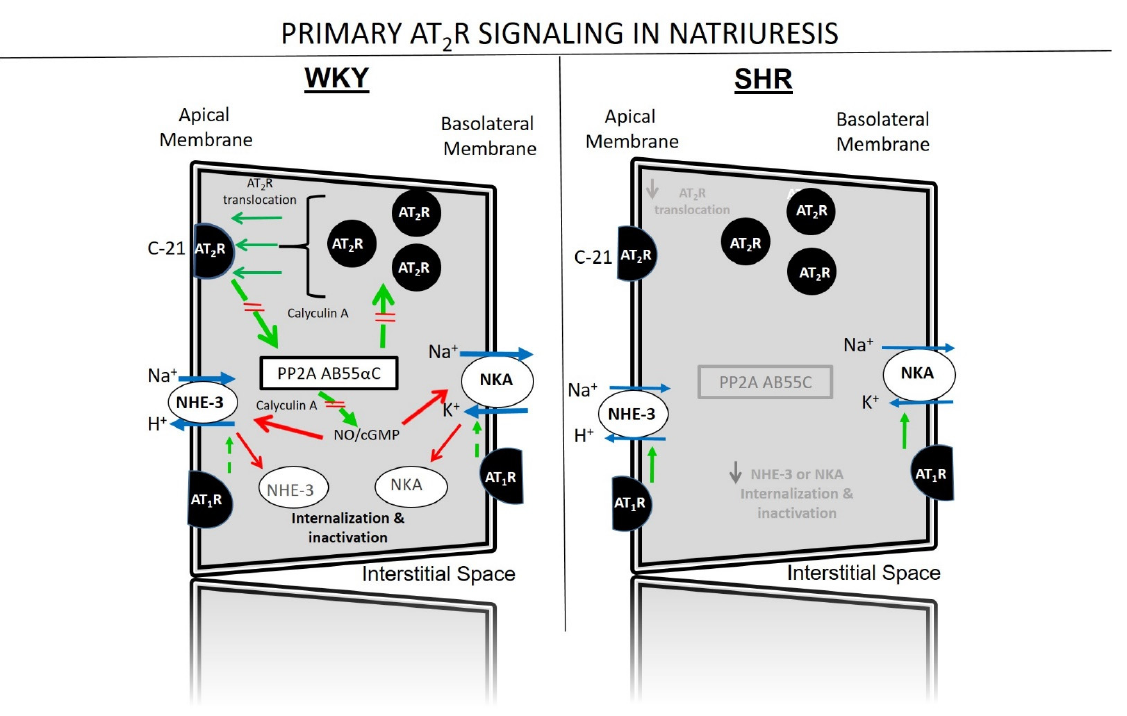
Figure 2. Schematic representation of the angiotensin II (Ang II) type 2 receptor (AT 2 R) protein phosphatase 2A (PP2A) AB55 α C signaling pathway by which receptor activation with Compound-21 (C-21) inhibits Na + reabsorption in the renal proximal tubule, increases cyclic GMP (cGMP) produc- tion, and induces natriuresis. Green arrows indicate stimulation; red arrows depict internalization and inactivation; red lines depict inhibition; blue arrows stand for effects on ion exchanges by Na + transporters; broken arrows indicate impaired/reduced responses. In Wistar-Kyoto rats (WKY, left), AT2R activation by exogenous non-peptide agonist C-21 stimulates AT2R recruitment from intracellular sites to the apical plasma membranes of renal proximal tubule cells via PP2A-depend- ent signaling, reinforcing and sustaining the natriuretic response. AT 2 R activation via a PP2A AB55 α C signaling pathway internalizes and inactivates major Na + transporter molecules Na + -H + - exchanger-3 (NHE-3) and Na + -K + -ATPase (NKA), counterbalancing angiotensin II (Ang II) type-1 receptor (AT 1 R) actions to increase Na + reabsorption by stimulating these transporters. In WKY, PP2A inhibition with calyculin A inhibits AT 2 R translocation, cGMP formation, and natriuresis. In spontaneously hypertensive rats (SHR, right) AT 2 Rs are defective resulting in markedly reduced apical plasma membrane translocation, failure to associate with and activate PP2A, and internalize and